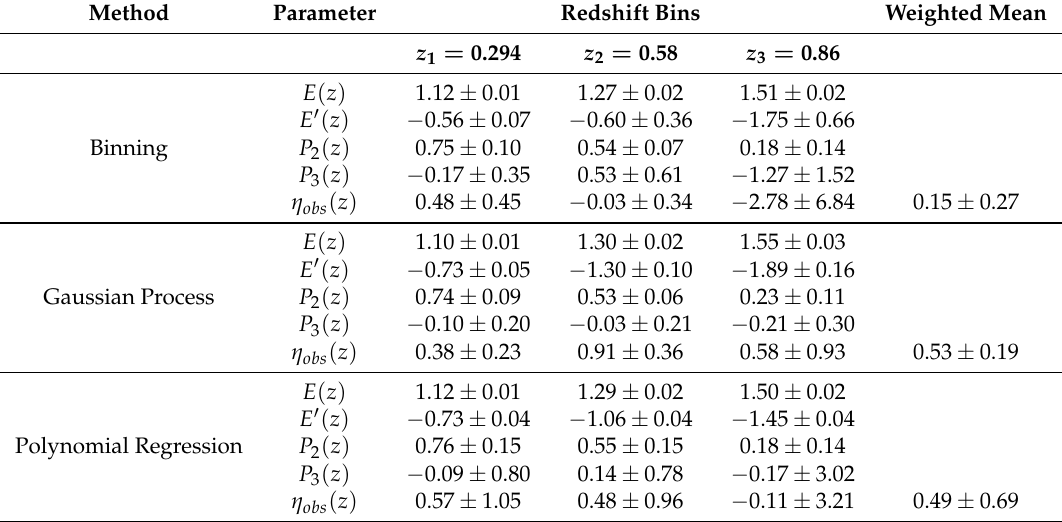
Table A2. The reconstructed or measured model-independent variables E , E (cid:48) , P 2 , P 3 , η ( z ) at three different redshifts z = ( 0.294,0.58,0.86 ) , together with their 1 σ errors, for each of the reconstruction methods. The polynomial regression method is compatible with the Λ CDM scenario, while the other two methods show some tension at lower